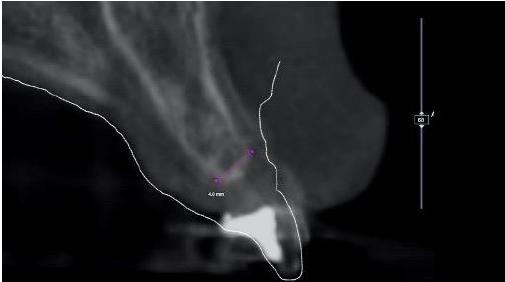
Figure 2. Virtual implant planning showing the implant sites with ≤ 4.0 mm bone in bucco-oral dimension, as measured on cone-beam computer tomography (CBCT) cross-sectional image.